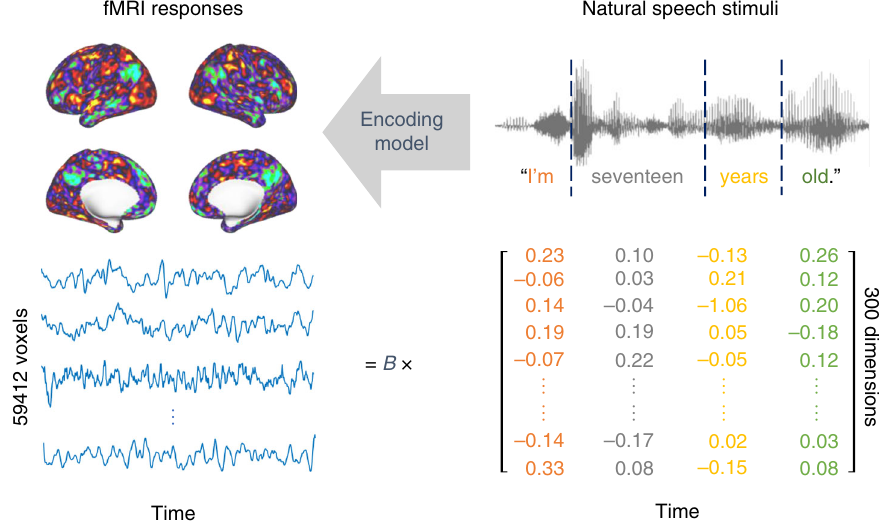
Fig. 1 Illustration of the encoding model. The encoding model was trained and tested for predicting the fMRI responses (top left) to a time series of words in audio-story stimuli (top right). Every word (as color coded) was converted to a 300-dimensional vector through word2vec. The encoding model was denoted as a 59,421-by-300 matrix (B) to predict the voxel response to every word (bottom).